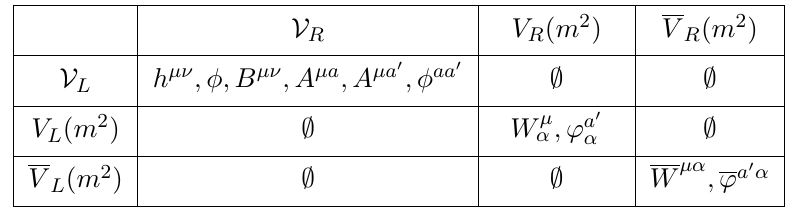
(cid:8)(cid:8) YM DR and YM + (cid:0)(cid:0) (cid:30) 3 . The bosonic spectra of the